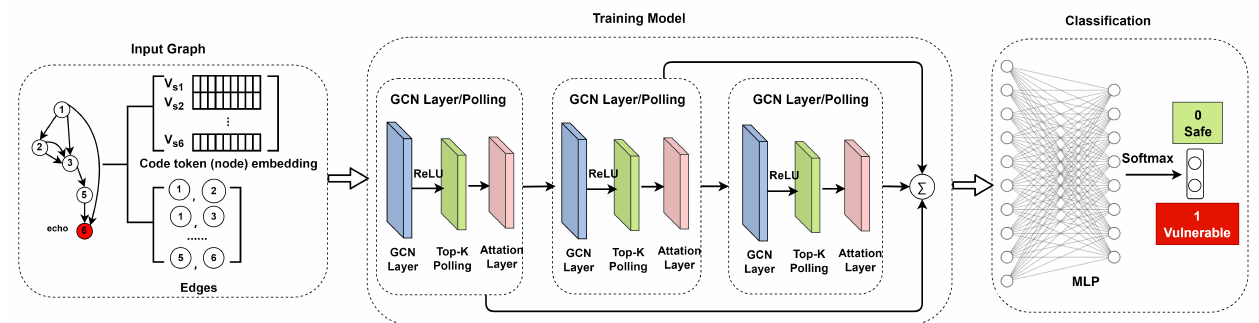
Figure 5. VulEye deep learning